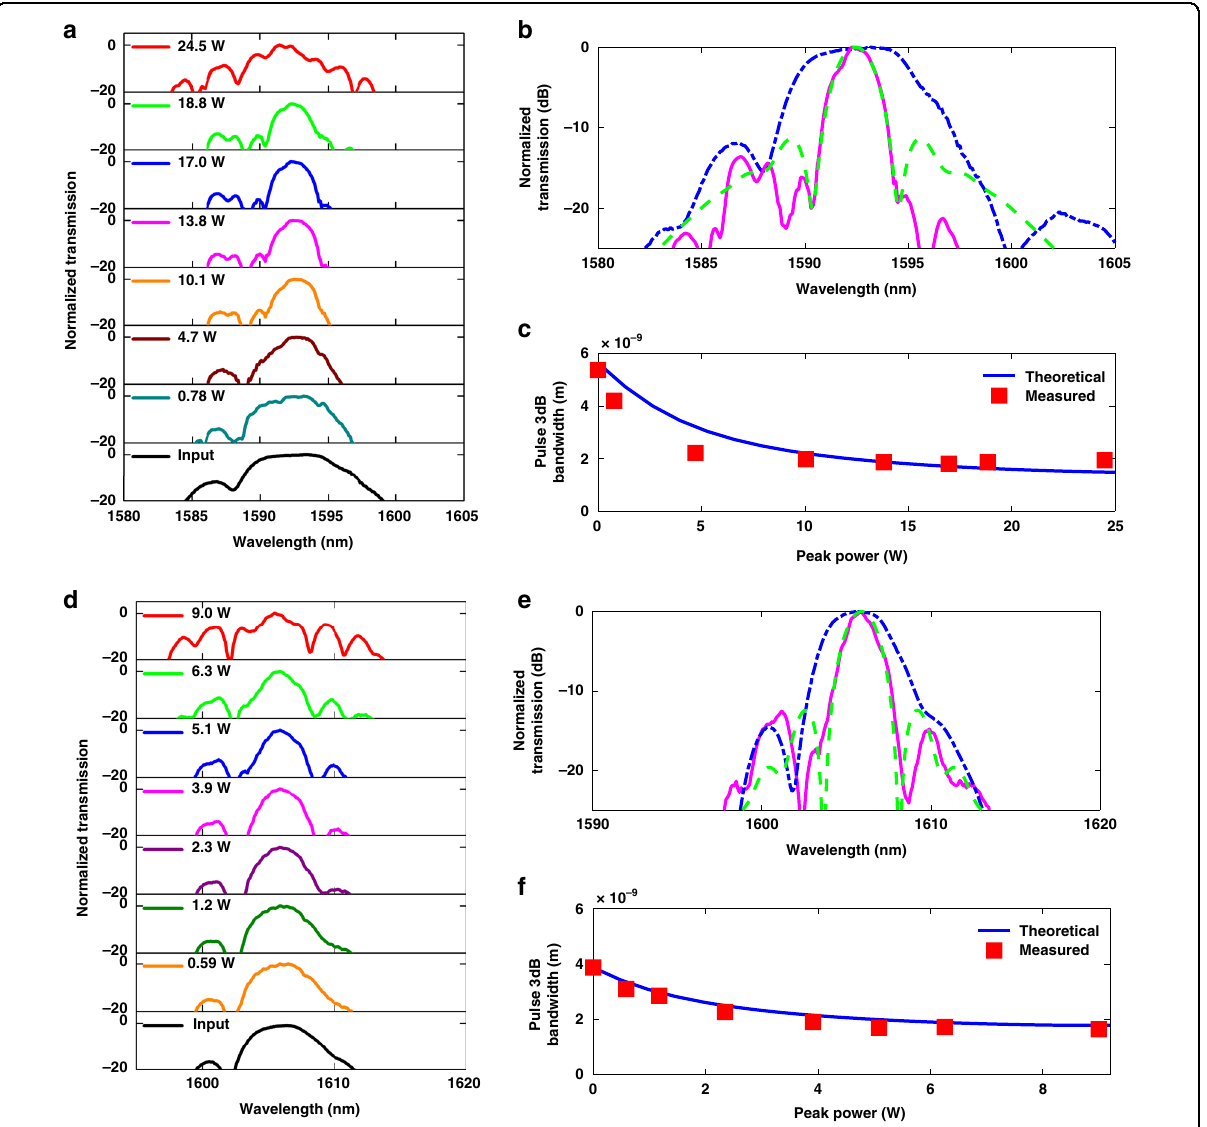
Fig. 6 Impact of dispersion magnitude of the grating stage on spectral compression. a Output pulses as a function of input peak power for T = 480 fs and β = − 1,600 ps 2 m − 1 . b Measured source (blue dashed line), compressed pulse (solid magenta line) and numerically FWHM 2(grating) compressed pulse (green dashed line) at optimal compression P peak(in) = 14 W (pulse energy = 6.7 pJ). c Measured (red squares) and numerically calculated (blue solid line) spectrally compressed pulse width as a function of input peak power. d Output pulses as a function of input peak power for T FWHM = 700 fs and β 2(grating) = − 1,600 ps 2 m − 1 . e Measured source (blue dashed line), compressed pulse (solid magenta line) and numerically compressed pulse (green dashed line) at optimal compression P peak(in) = 5 W (pulse energy = 3.5 pJ). f Measured (red squares) and numerically calculated (blue solid line) spectrally compressed pulse width as a function of input peak